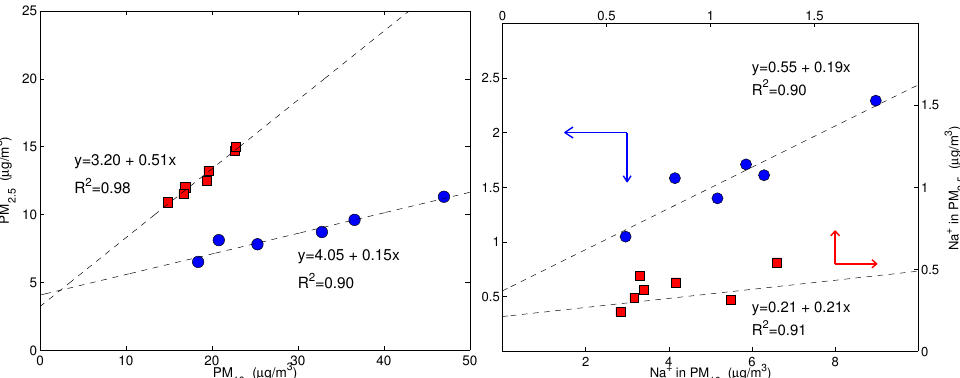
Figure 5. On the ( left ), the PM 2.5 concentration is plotted against PM 10 ; on the ( right ), the sodium concentration in PM 2.5 is plotted against the sodium in PM 10 . Both plots are for Capo Granitola only. The blue dots and red squares represent the samples of two distinct periods: from 25 November to 1 December and from 3 December to 9 December, respectively. Note that for sodium, there are two scales; the red axes, corresponding to the red squares, refer to the upper-right frame and the blue axes, corresponding to the blue dots, refer to the lower-left frame, as indicated by the arrows. The dashed lines are the robust fits for each set of data. The coefficient values are significantly different from zero at p -values of lower than